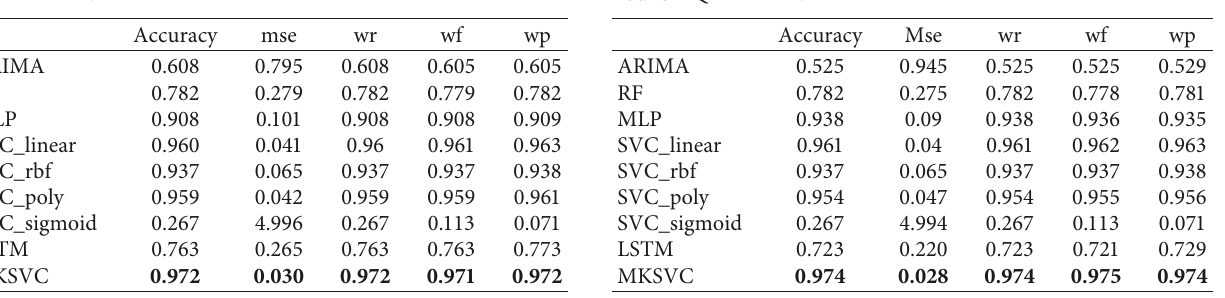
Table 8: Performance comparison for predicting the future